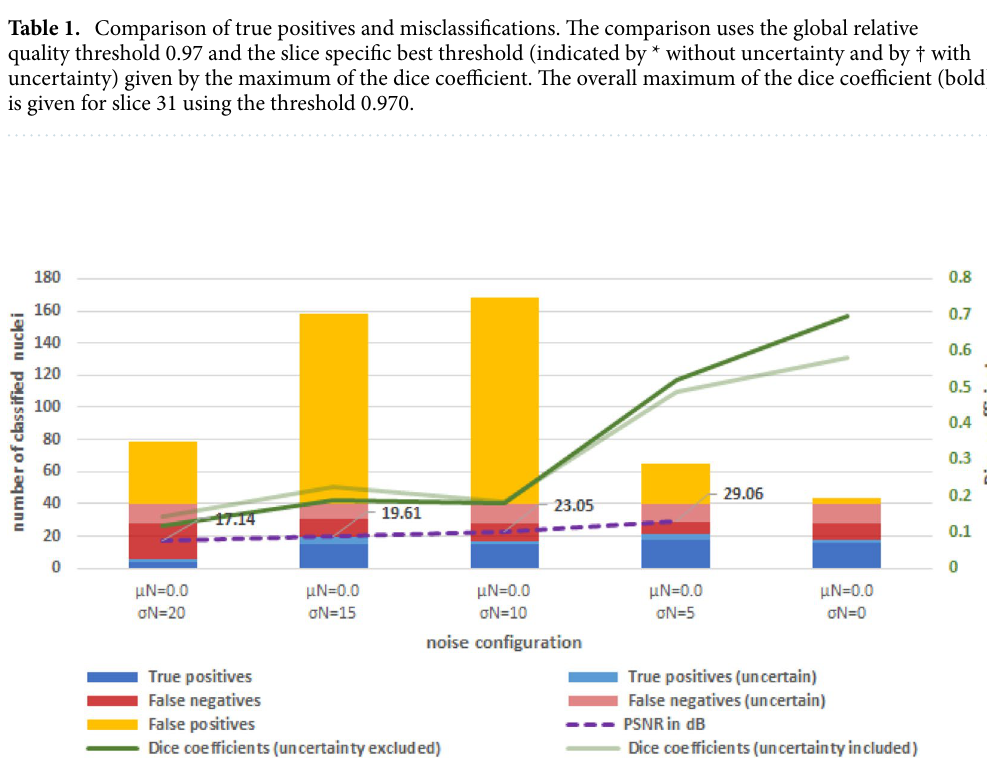
Figure 9. Classification results for noisy images. Summation of all true positives and misclassifications (left ordinate) for slice 30, PSNR in respect to image with µ N = 0 and σ N = 0.0 and Dice coefficient (right ordinate). The number of total nuclei from ground truth is 40 (including certain and uncertain